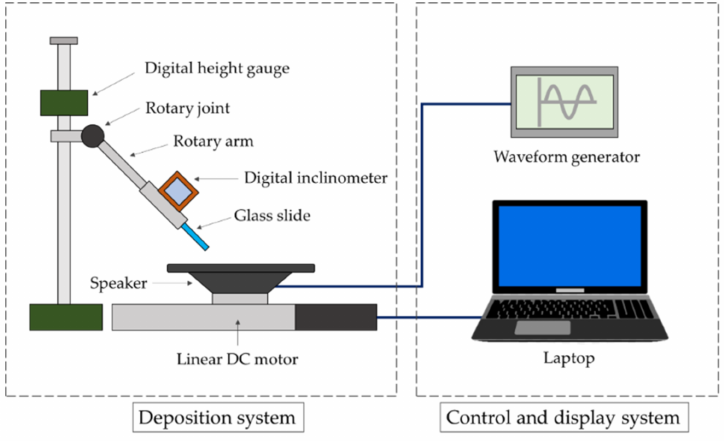
Figure 1. Schematic representation of the whole setup of the VVBC.